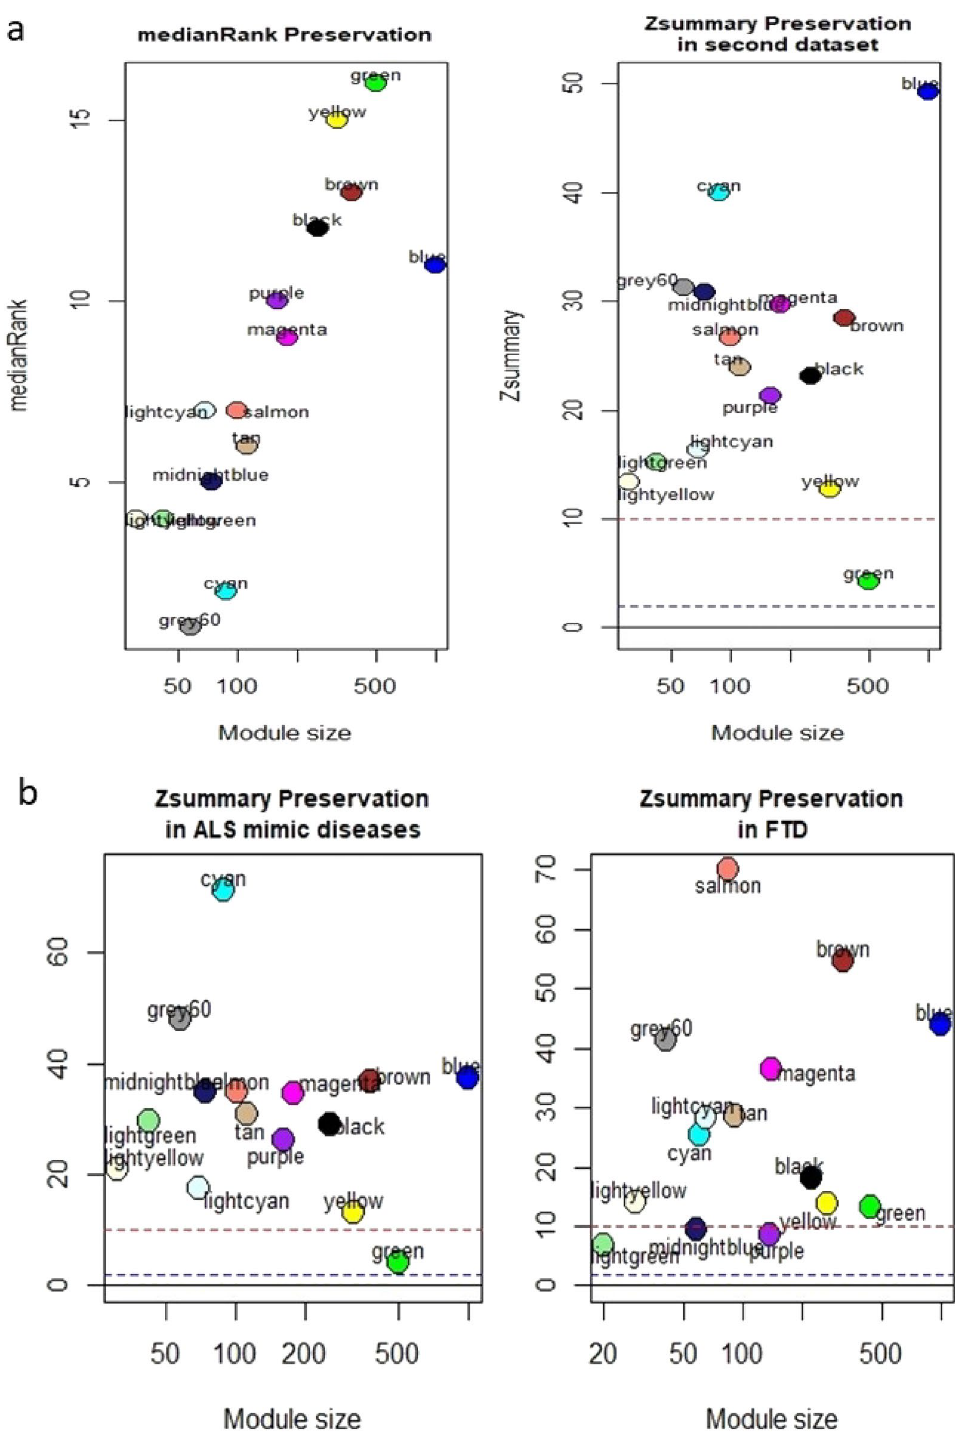
Figure 2. The median rank and Z-summary statistics of the module preservation in validation dataset and ( a ) and the Z-summary of module preservation in ALS mimic diseases and FTD ( b ). The dashed blue and red lines in the graphs indicate the thresholds Z = 2 and Z = 10, respectively. These horizontal lines indicate the Zsummary thresholds for strong evidence of conservation (> 10) and for low to moderate evidence of conservation (> 2). All the modules are strongly